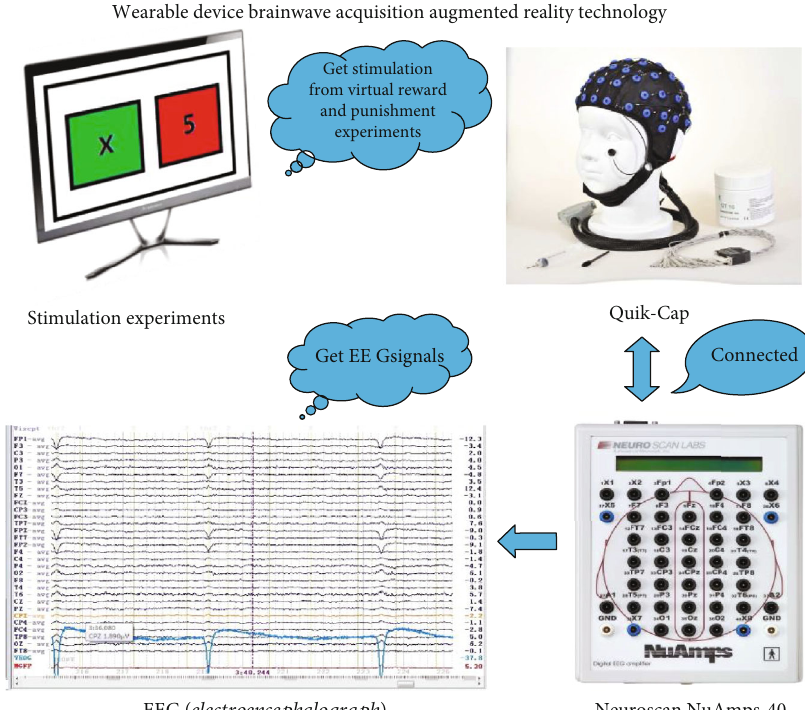
Figure 1: Wearable device EEG acquisition augmented reality